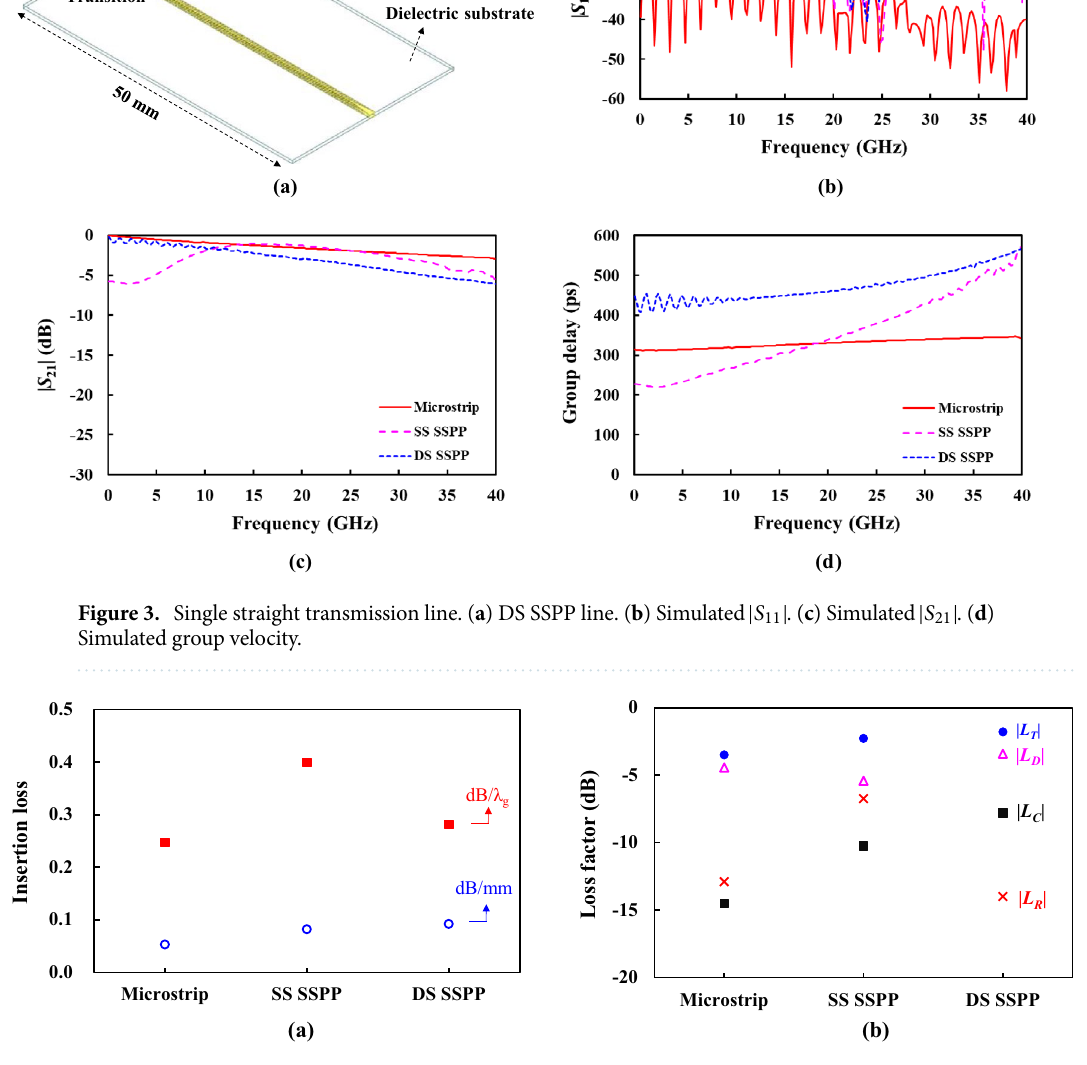
Figure 4. Loss analysis of straight transmission lines at 35.0 GHz. ( a ) Calculated insertion loss per unit length and per a wavelength. ( b ) Loss